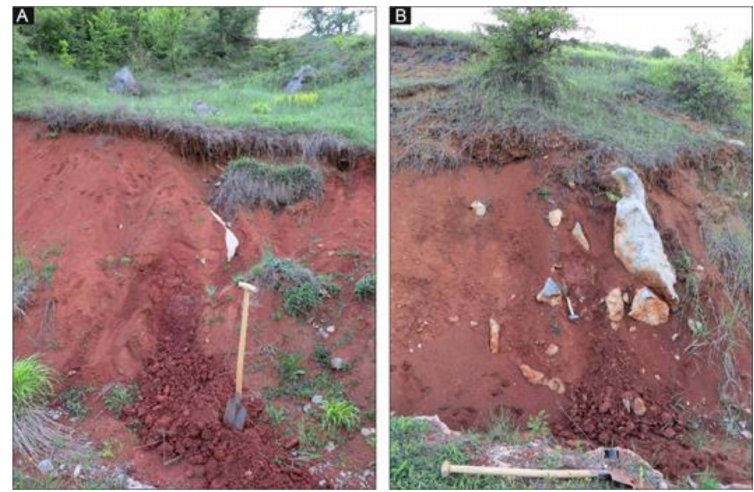
Figure 3. Terra rossa-type soil outcrops. ( A ) source of the Balta 1 OSL sample; ( B ) source of the Balta 2 OSL sample.